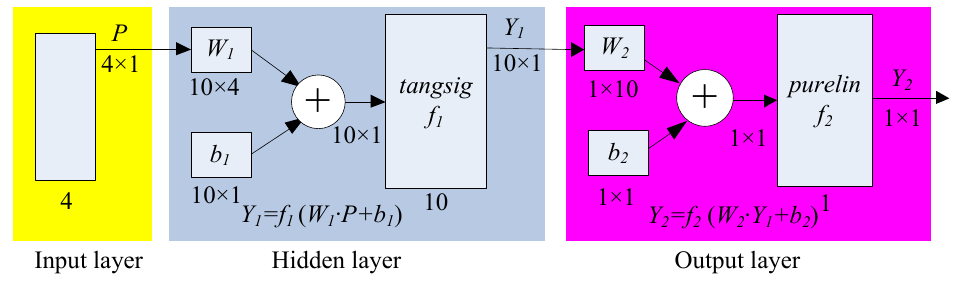
Figure 4. BPNN structure to fuse the HRD computing